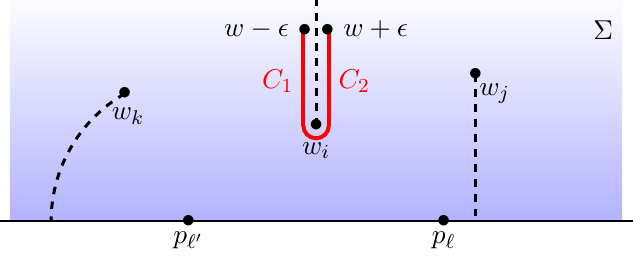
Figure 2 . Integration contour C = C 1 [ C 2 , where C 1 denotes the left half of the contour shown in red and C 2 the right